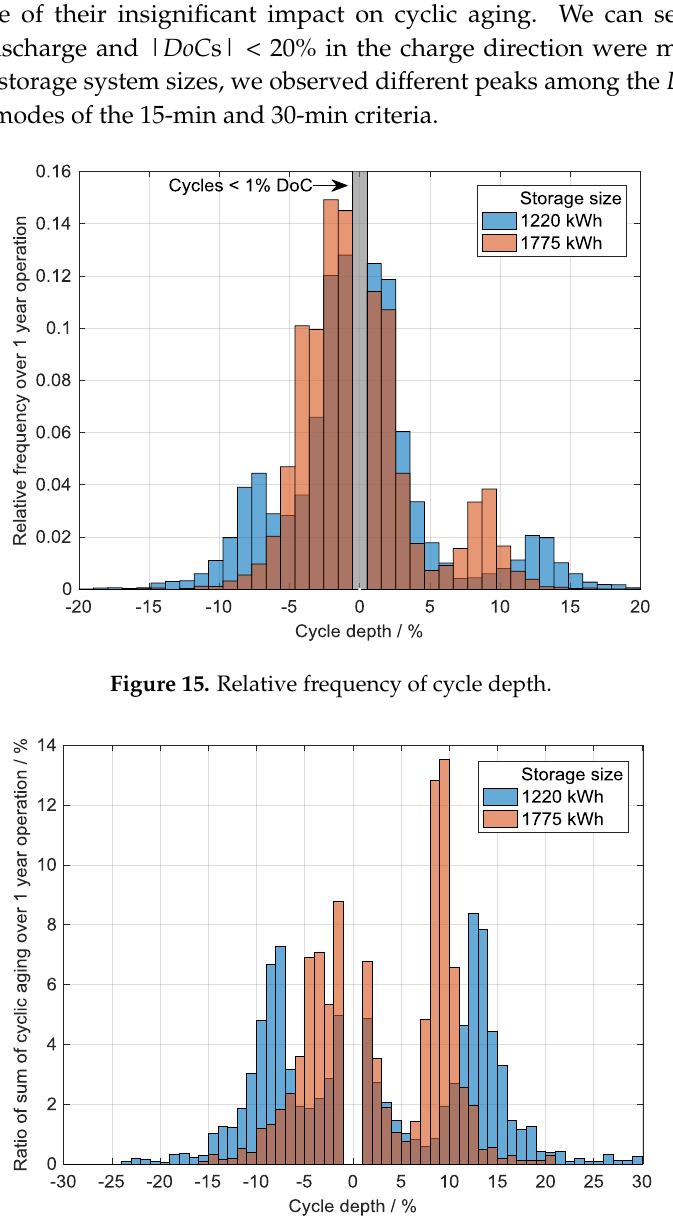
Figure 16. Percentage of cyclic aging versus cycle depth.